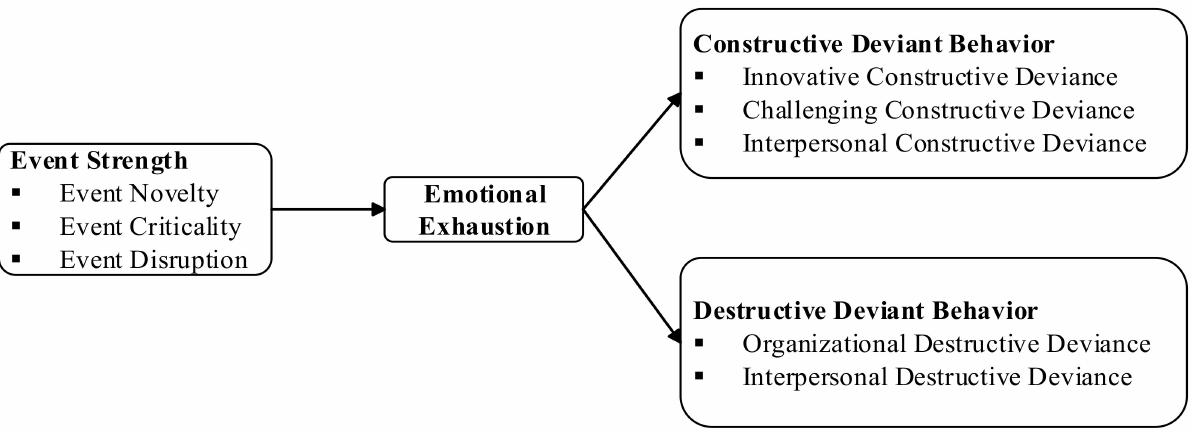
Figure 1. Theoretical